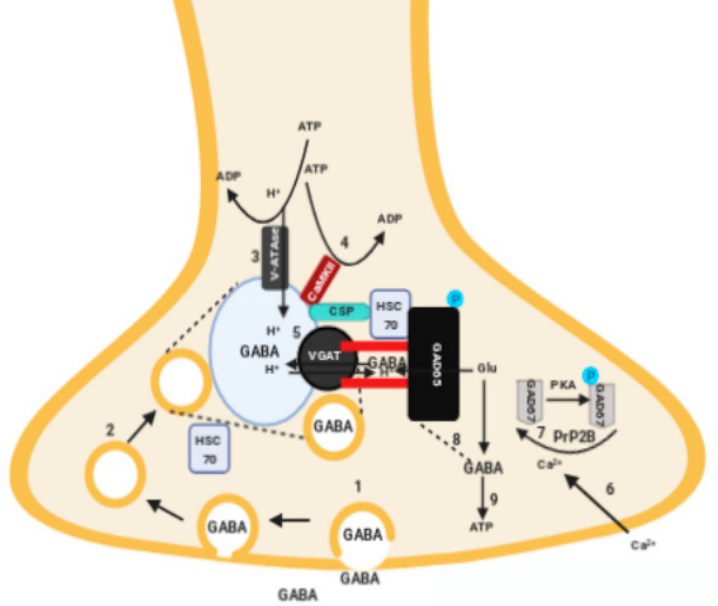
Figure 1. The structural coupling between gamma-aminobutyric acid (GABA) synthesis and vesicular GABA transport into a synaptic vesicle (SV). GAD65 is anchored to SVs through a protein complex with the chaperone HSC70, followed by association of HSC70-GAD65 complex to Cysteine-String Protein (CSP), Vesicular GABA transporter (VGAT) and Calcium / calmoduline protein kinase (CaMKII) on SVs. The numbers indicate the different required steps.